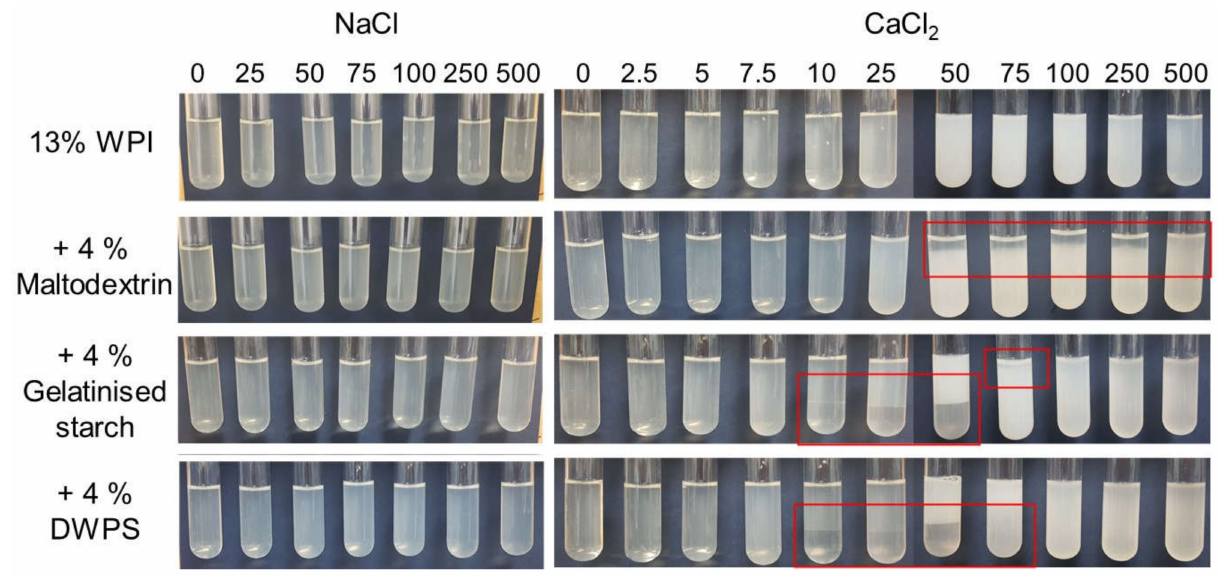
Figure 1. Effect of NaCl (0, 25, 50, 75, 100, 250, and 500 mM) and CaCl 2 (0, 2.5, 5, 7.5, 10, 25, 50, 75, 100, 250, and 500 mM) on the phase stability of 13% w / w whey protein isolate (WPI) solutions and mixtures of 13% w / w WPI + 4% w / w maltodextrin or gelatinised starch or de-structured waxy potato starch (DWPS) after 24 h of storage at 20 ◦